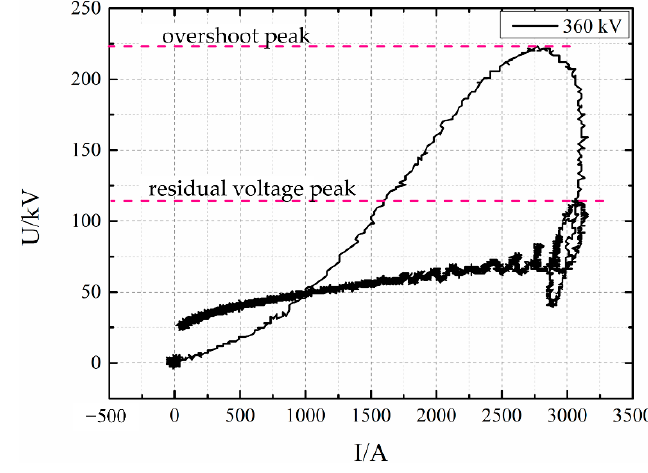
Figure 4. The volt–ampere characteristic curve of the arrester.